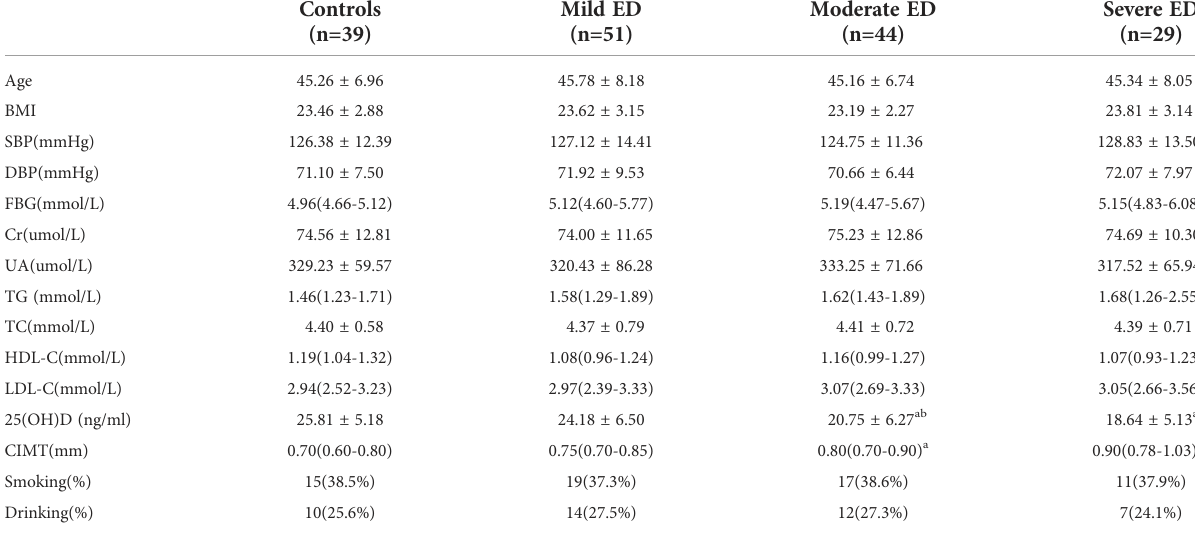
TABLE 1 Clinical and laboratory features of